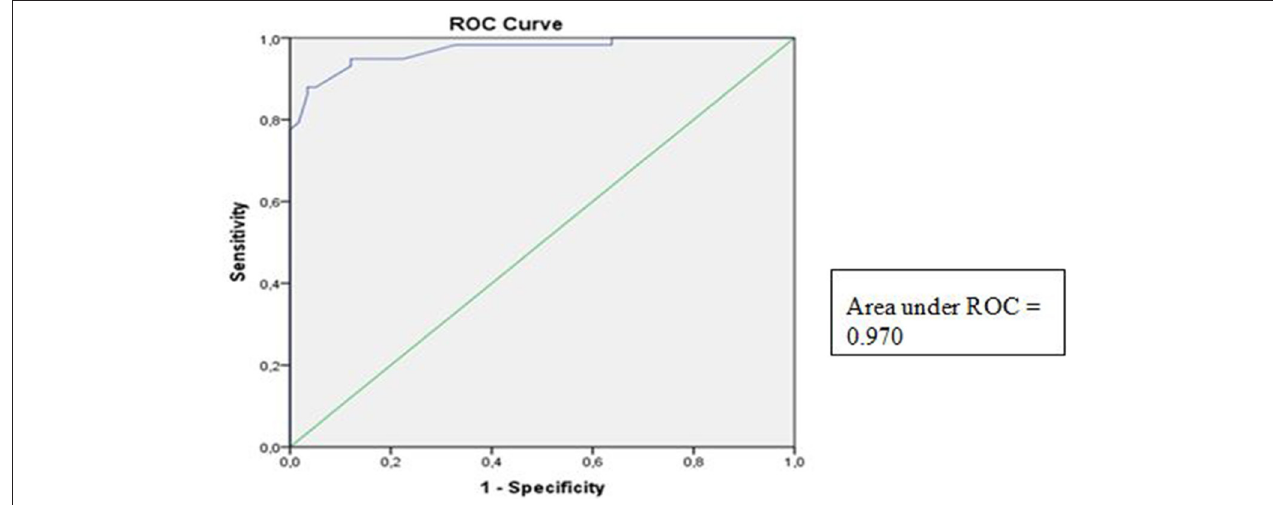
FIGURE 3 | Receiver operator curve for piriformis muscle thickness.